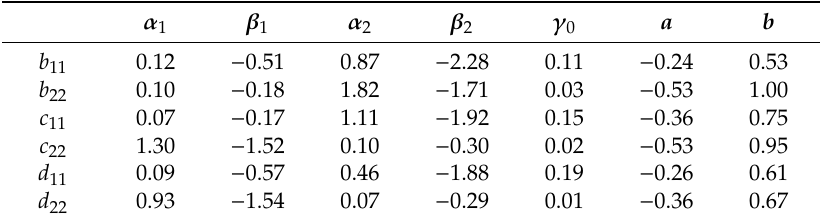
Table 1. Values of α 1 , β 1 , α 2 , β 2 , γ 0 , a , and b as parameters appearing in closure coe ffi cients.